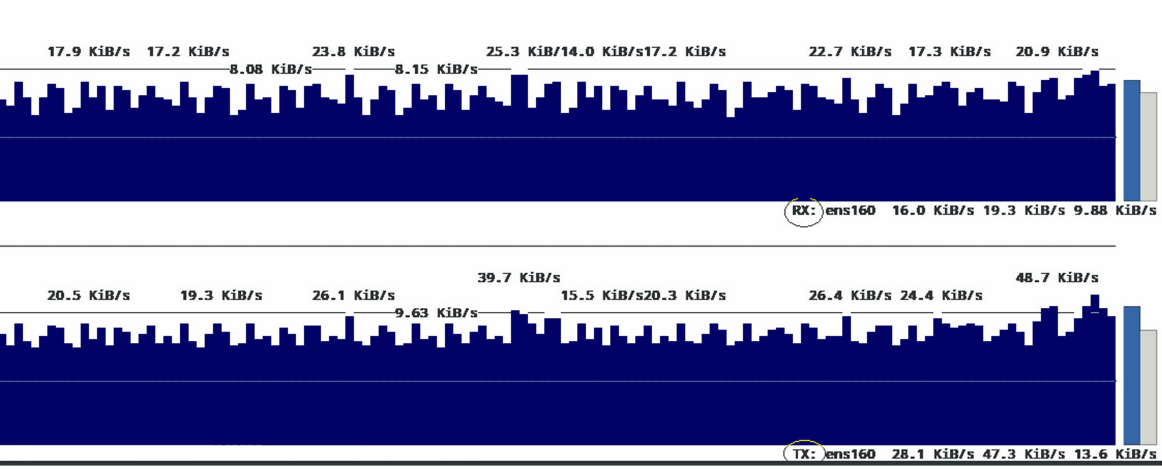
Figure 16. Network use for peer process with no transactions.